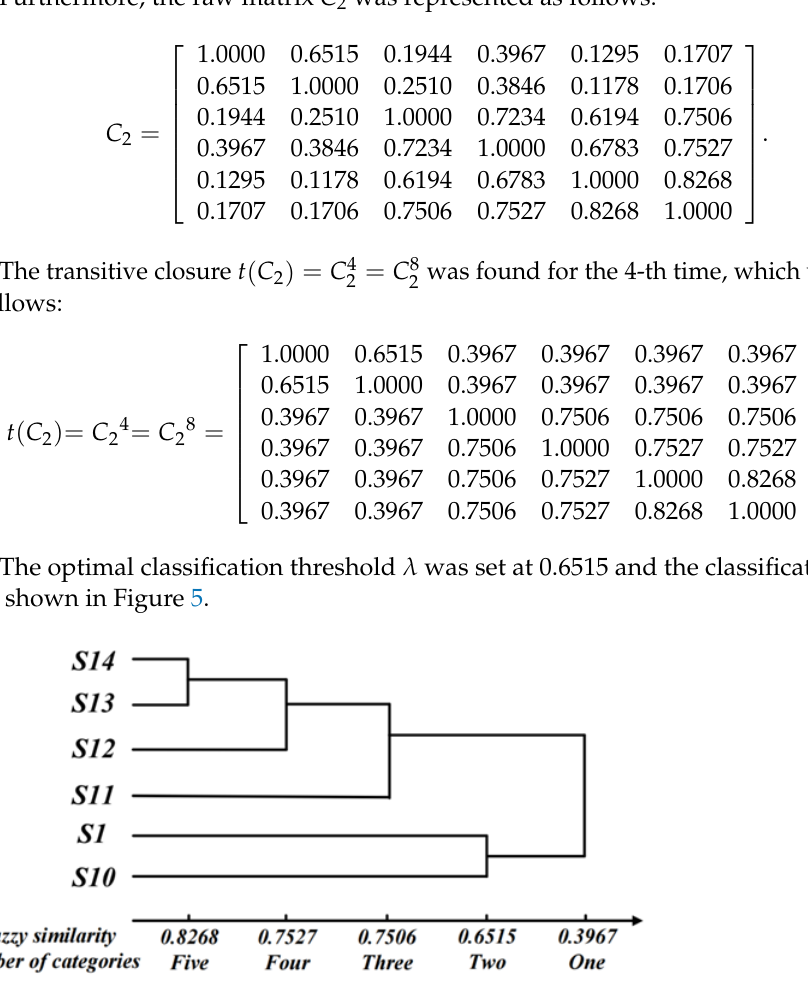
Figure 5. Fuzzy clustering analysis results for water gushing samples in the tunnel.